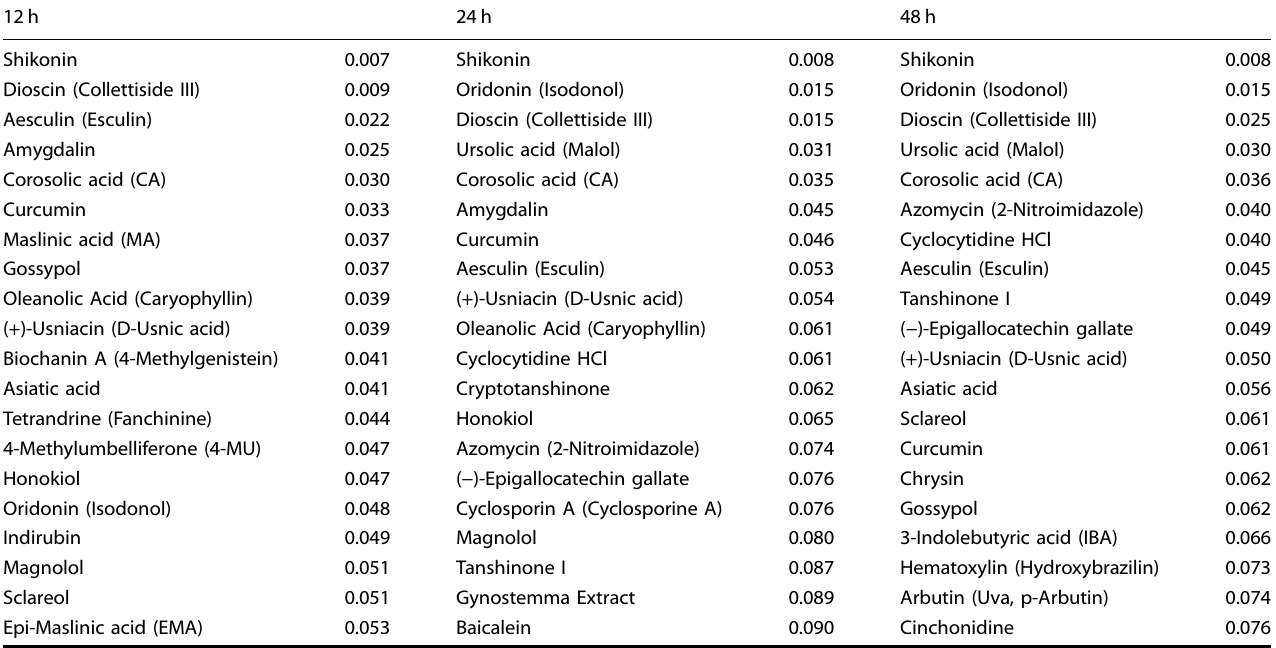
Table 1. Cell viability modulation following combined treatment with UA and the NCL compounds 12